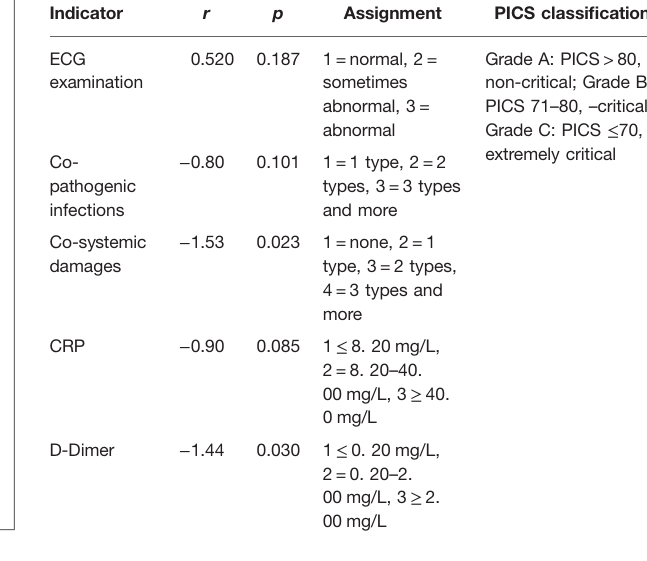
TABLE 2 | Multivariate Logistic regression analysis of PICS classi fi cation and clinical characteristics in 120 children. Indicator